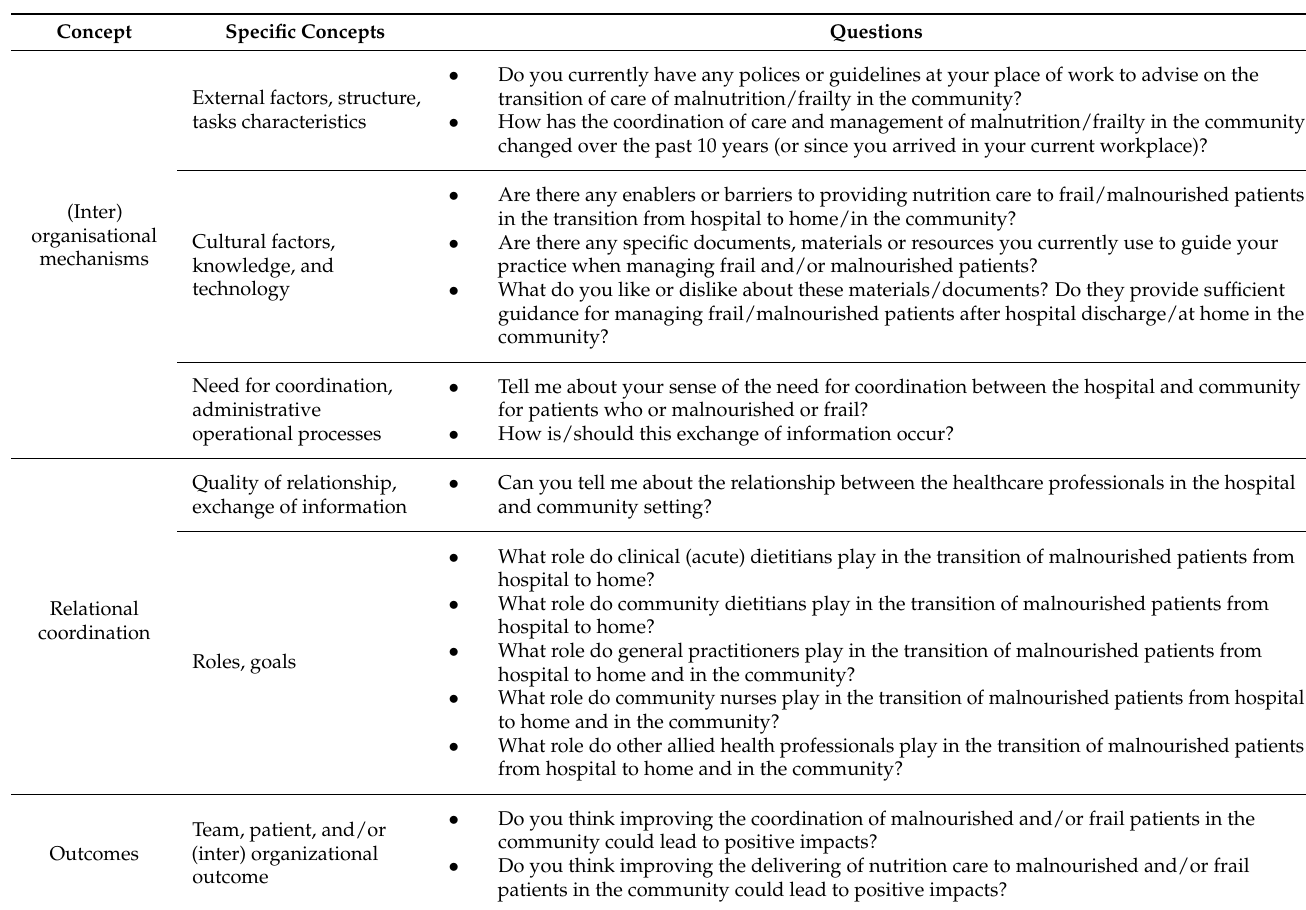
Table 1. Semi-structured interview